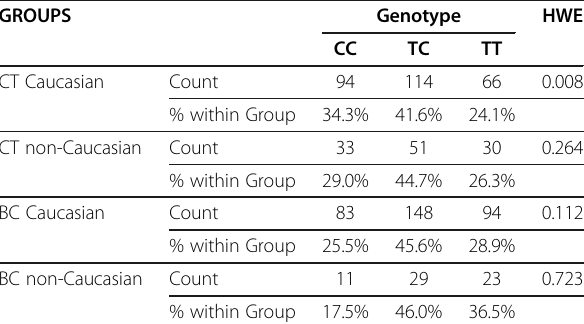
Table 3 Genotype distribution in the CT and BC groups